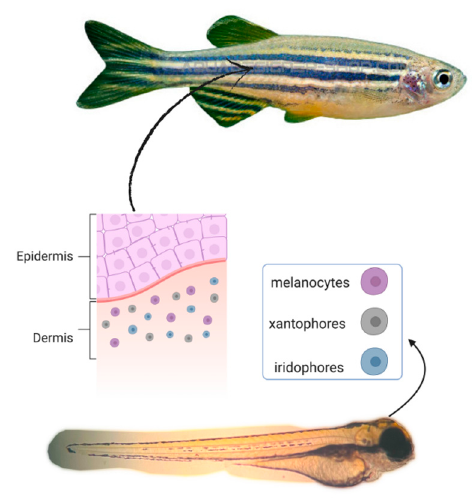
Figure 2. Zebrafish pigment cells include xanthophores (xp), iridophores (ip) and melanophores (mp). The main external barrier is the epidermis, which consists of two layers of cells connected by tight junctions. Certain substances can pass through the epidermis mesenchymal space by diffusion or by active transport (adapted from Irene et al. [67]).